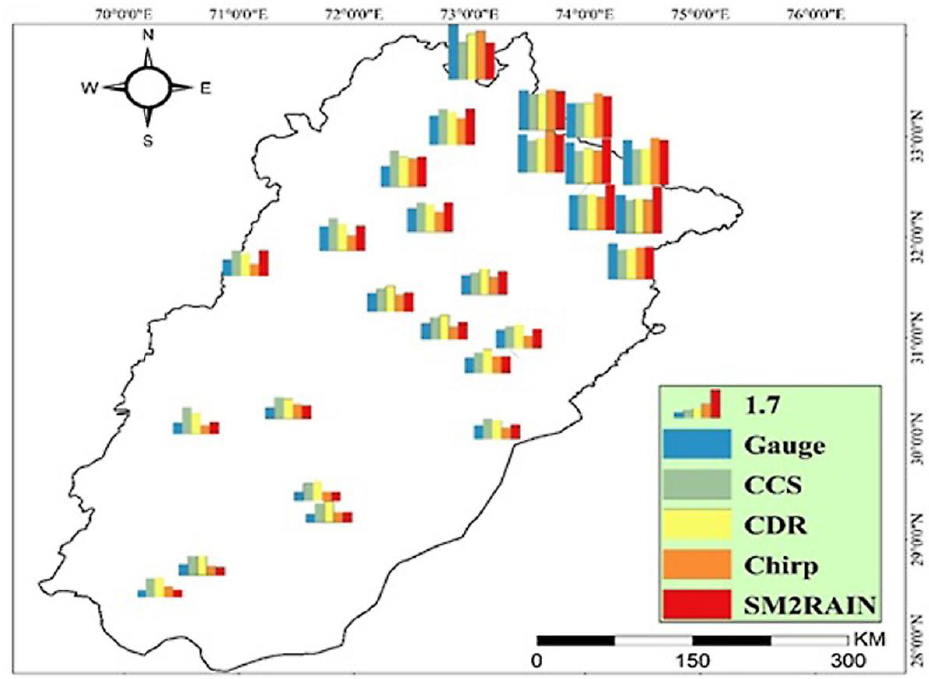
Figure 2. Spatial variation of the average daily rainfall amount obtained from the in situ weather stations and satellite products (CHIRPS 2.0, PERSIANN-CCS, PERSIANN-CDR, and SM2RAIN- ASCAT) from 2010 to 2018.